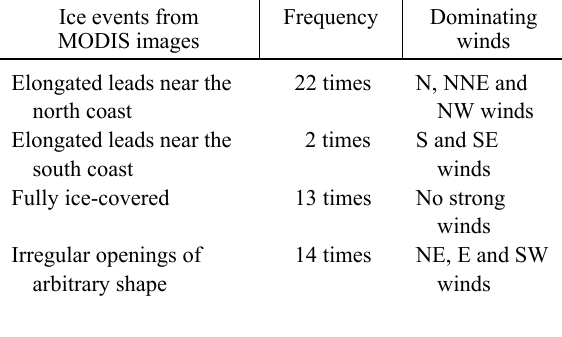
Table 2. Occurrence of natural leads in the Gulf of Finland in the winter of 2003 from MODIS images Ice events from MODIS images Elongated leads near the north coast Elongated leads near the south coast Fully ice-covered 13 times No strong Irregular openings of arbitrary shape